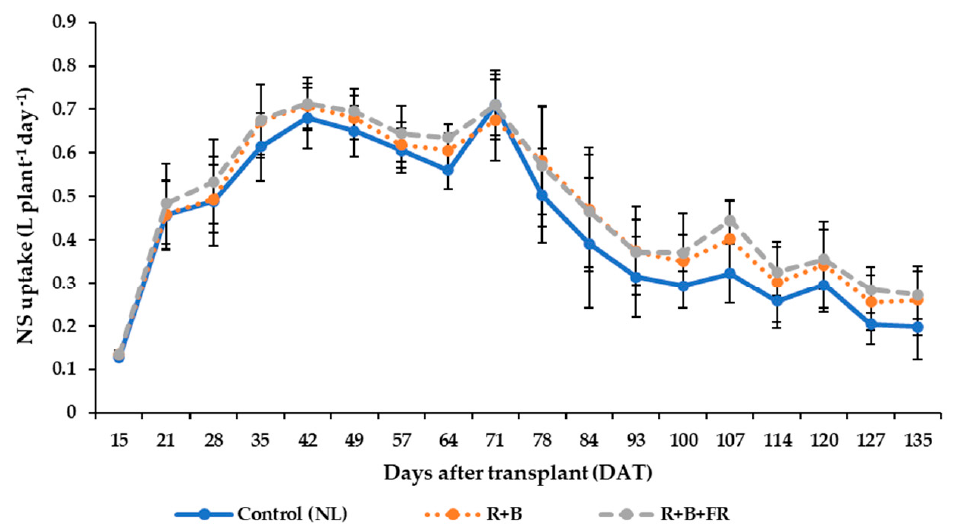
Figure 7. Nutrient solution (NS) uptake per plant per day during the growth cycle under control (NL), R + B + FR, and R + B light conditions. Vertical bars represent ± standard deviation of mean values.